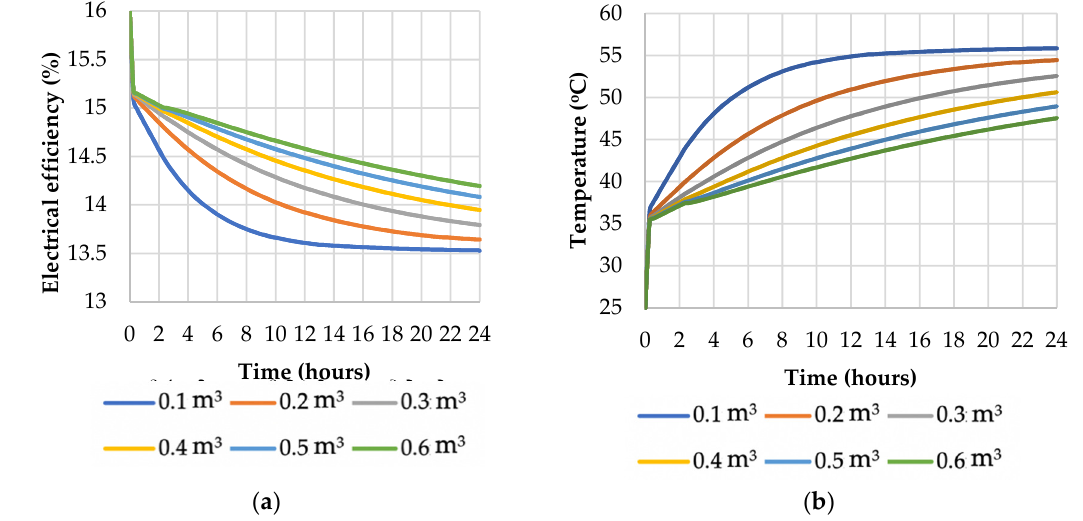
Figure 10. The variation of the ( a ) electrical efficiency; ( b ) cell temperature; as a function of the tank volume.